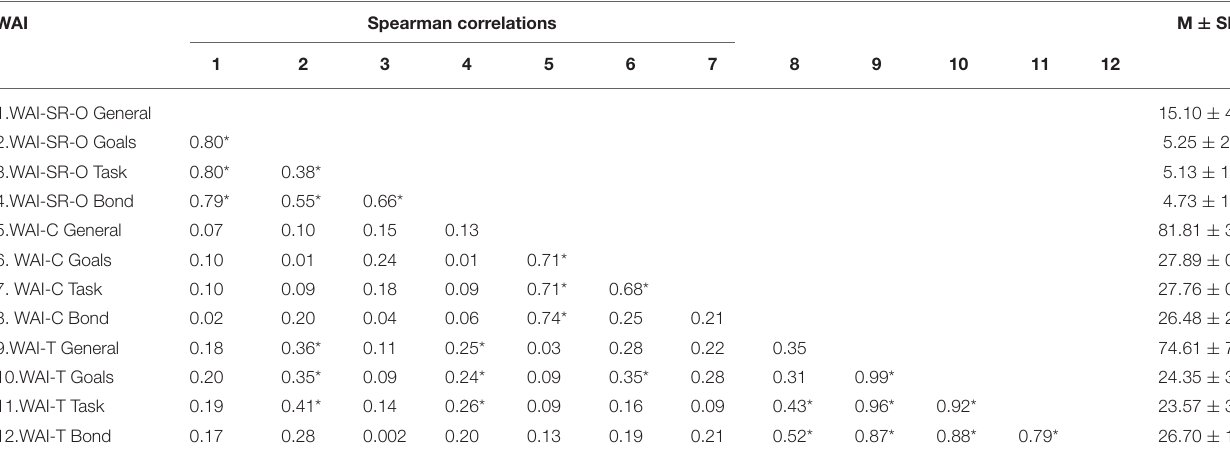
TABLE 3 | Spearman correlations of WAI-SR-O, WAI-T, and WAI-C. WAI Spearman